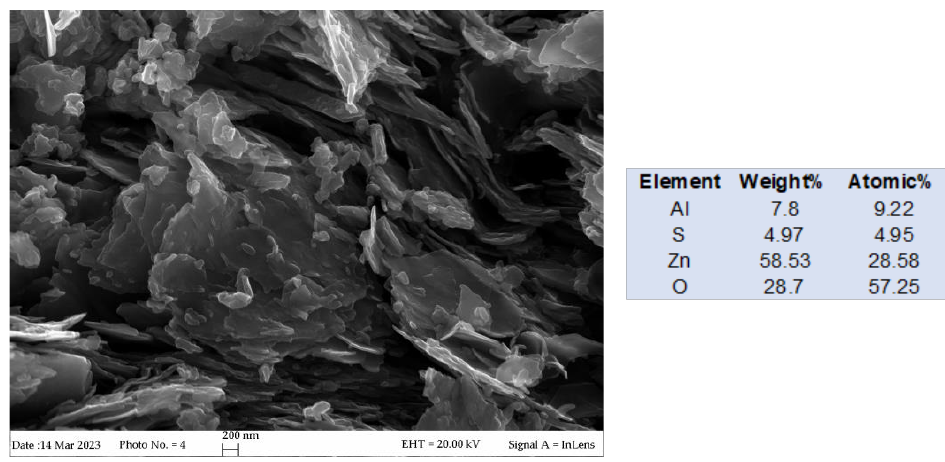
Figure 3. FESEM image of the ZnAl-MMO morphology and composition.